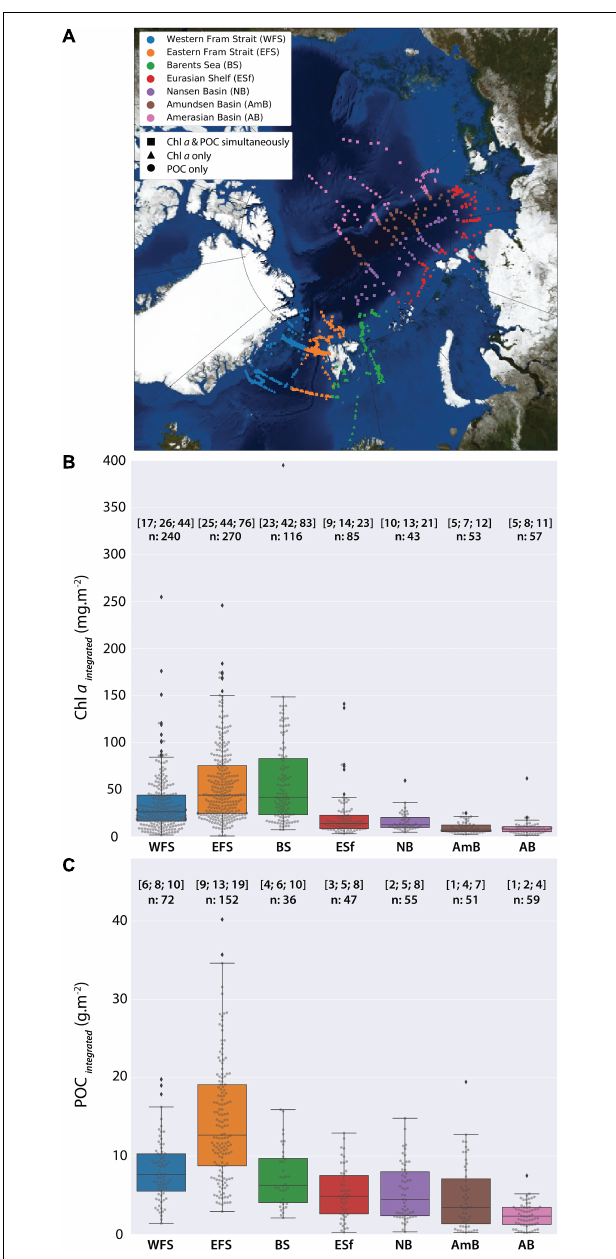
FIGURE 4 | (A) Sub-regions for the comparison of regional differences. Western Fram Strait (WFS), eastern Fram Strait (EFS), Barents Sea (BS), Eurasian shelf (ESf), Nansen Basin (NB), Amundsen Basin (AmB), and Amerasian Basin (AB, including Makarov and Canadian basins); (B) Chl a values (mg m − 2 ) and, (C) POC values (g m − 2 ) integrated over 0–100 m from 1991 to 2015. Black line represents the median; numbers in the brackets on the top are the 1st, 2nd (median), and 3rd quantile, n, number of data points.